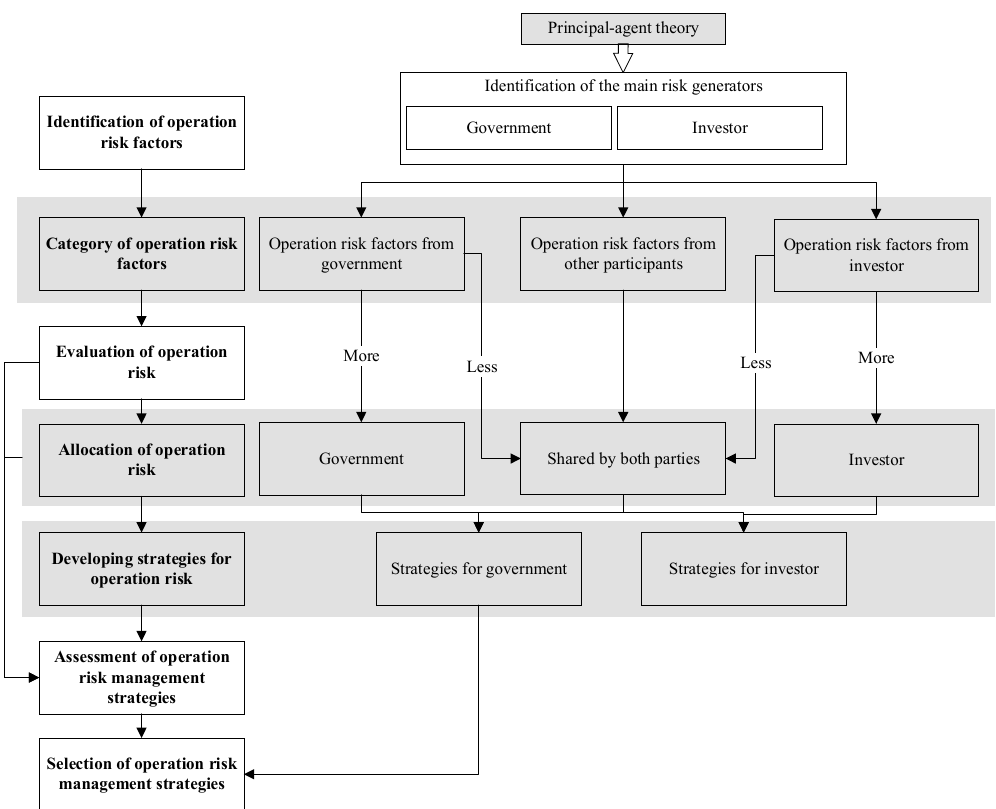
Figure 6. Operational risk management flow.